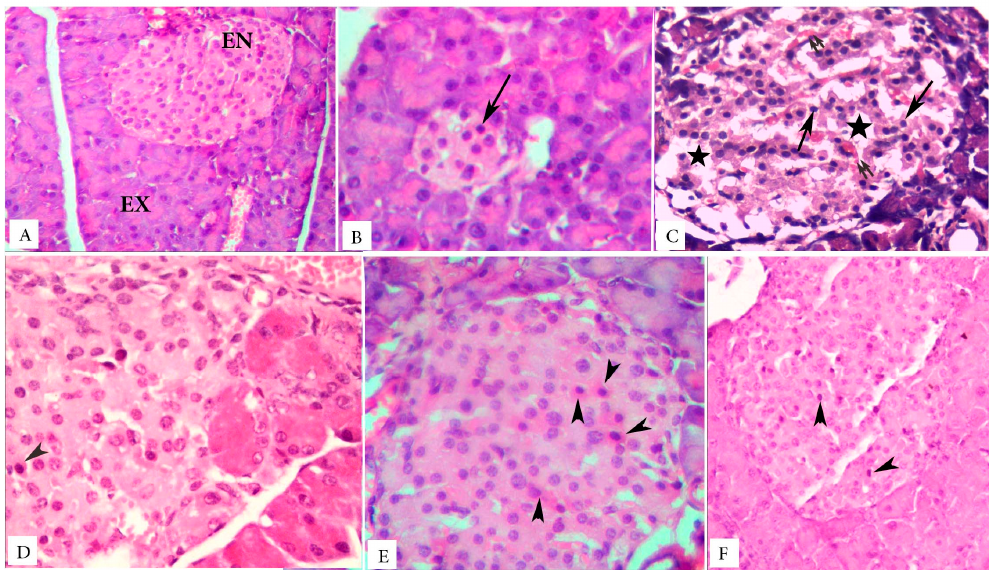
Figure 4. H&E stained microscopic photomicrographs of the different studied groups. ( A ). Control rats show the endocrine pancreas (EN) with histologic features of normal islets. The exocrine pancreatic acini (EX) appear with normal pyramidal lining cells, showing basal basophilia and apical acidophilia. ( B , C ). The untreated diabetic group shows shrunken islets with a drastic decrease in the number of their cells. Some islet cells are distorted with vacuolated cytoplasm (stars), small-sized darkly stained nuclei (arrows), and congested blood capillaries (double arrows) in-between. ( D ). The sitagliptin-treated group shows an apparent increase in islet size and normal histoarchitecture. Few islet cells show small, deeply stained nuclei (arrowheads). Pancreatic acini appear closed packed with normal histology ( E ). Metformin-treated group shows an apparent improvement in the islet size, normal cellular arrangement. Apoptotic changes, in the form of small pyknotic nuclei and deeply acidophilic cytoplasm (arrowheads), are seen. ( F ). The combined therapy group shows improved islet size, histoarchitecture, and cytology. Apoptotic nuclei (arrowheads) are also seen. The pancreatic acini appear normal. Magnification: ( A , F ) ×200, ( B – E ) ×400.